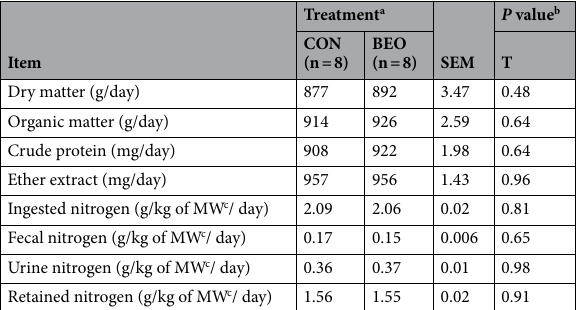
Table 4. Apparent nutrient digestibility % and nitrogen balance of control bull calves (CON) and bull calves supplemented with a blend of essential oils (BEO) in milk replacer from 4 to 60 days of age. a CON = control;